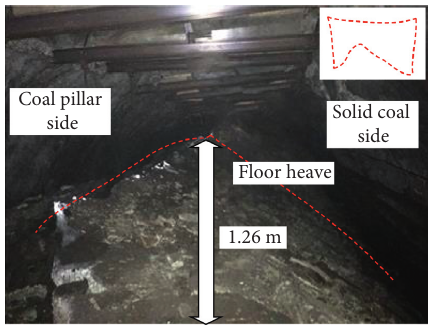
Figure 2: Floor heave of return airway in no. 130203 working